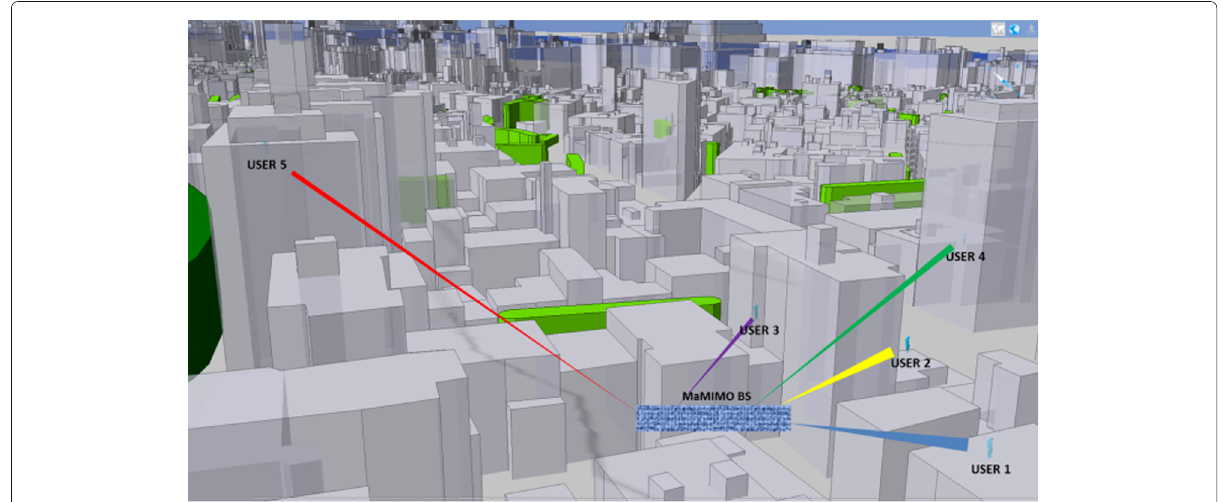
Fig. 7 Illustration of the outdoor and indoor user distribution on multiple floors of a typical North American city